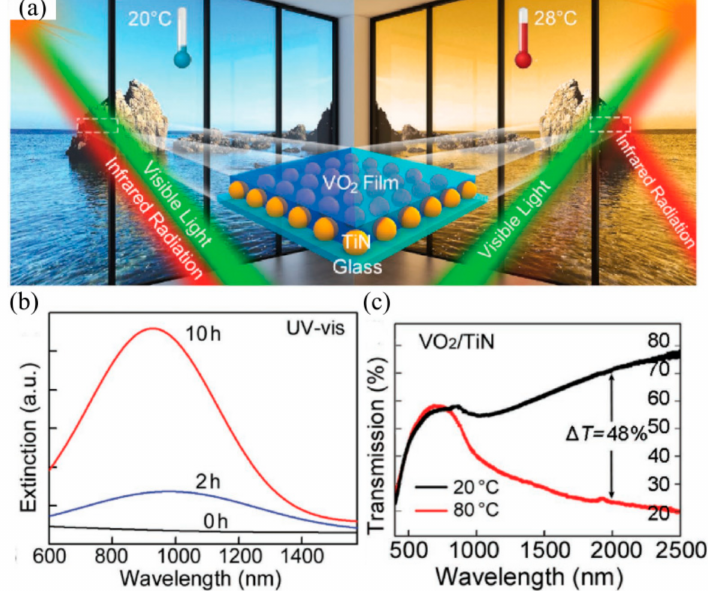
Figure 2. ( a ) Schematic diagram of VO 2 /TiN smart windows. ( b ) UV-Vis spectra of TiO x (0 h), TiO x N y (2 h), TiN (10 h) nanoarrays on quartz substrate. ( c ) Transmission spectra of VO 2 /TiN coatings at 20 ◦ C and 80 ◦ C. Reproduced with permission from [21]. Copyright 2018,